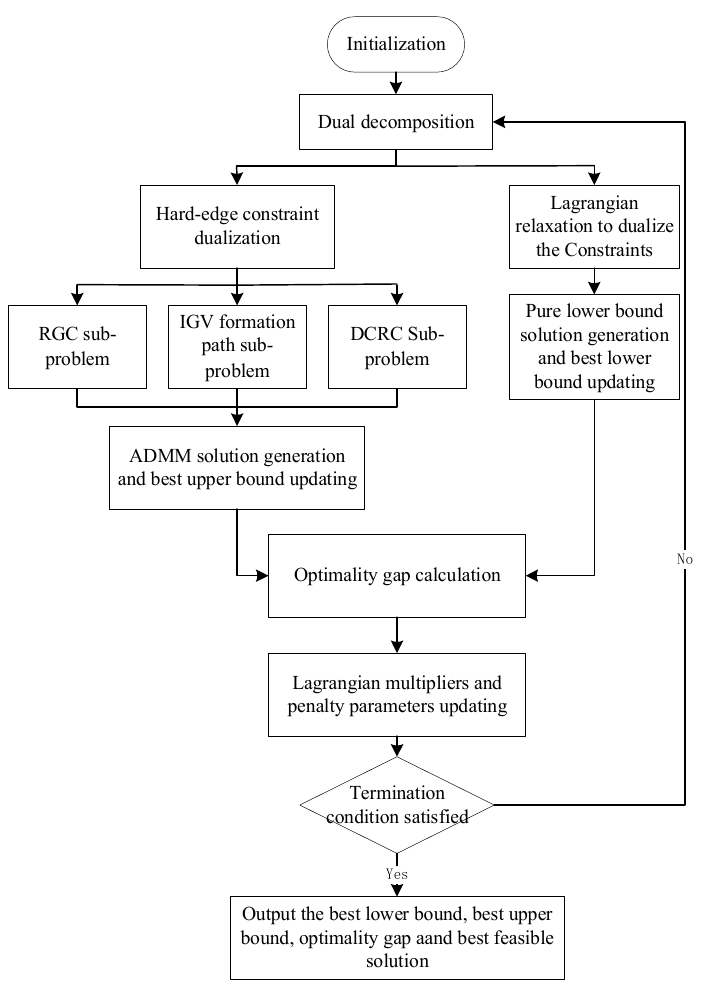
Figure 7. ADMM-based solution framework. Note that “hard-edge constraint dualization” denotes that ADMM dualize the constraints of the equations of (28), (29), (2), (8), (15), (21).